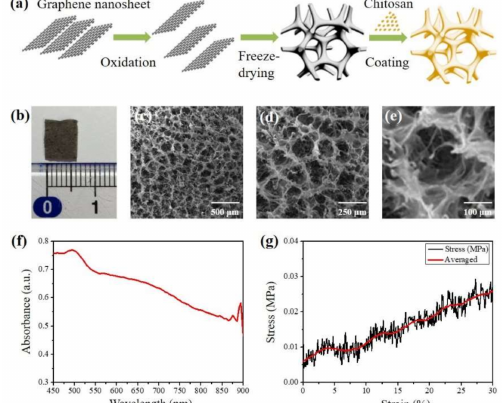
Figure 2. Preparation route and characterization of the Chi-GO hemostatic sponge. ( a ) Preparation route of hemostatic sponge. ( b ) Photograph of the cross-section of the sponge. ( c – e ) SEM image of the porous structure of the sponge at indicated magnification scale. ( f ) Absorbance spectrum. ( g ) The stress–strain curve in the mechanical compression